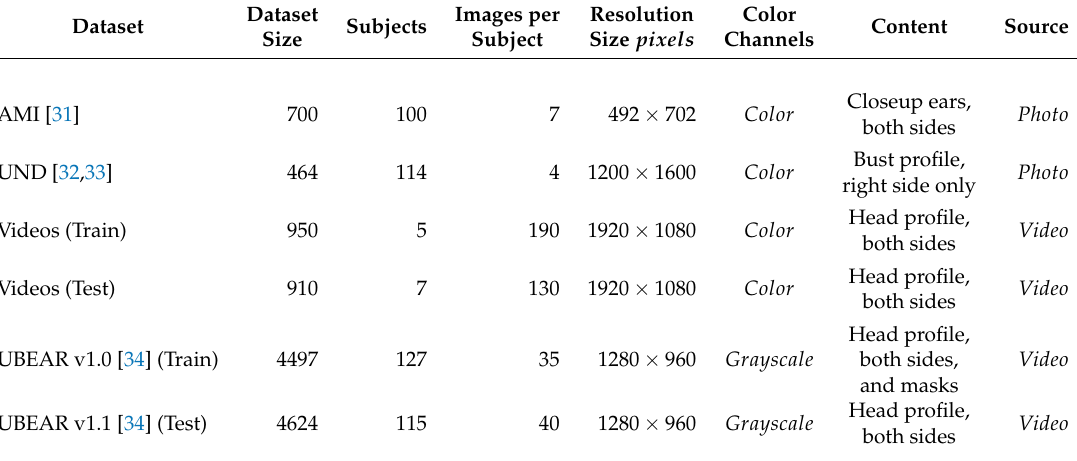
Table 2. Details on the contents of the various datasets used in this